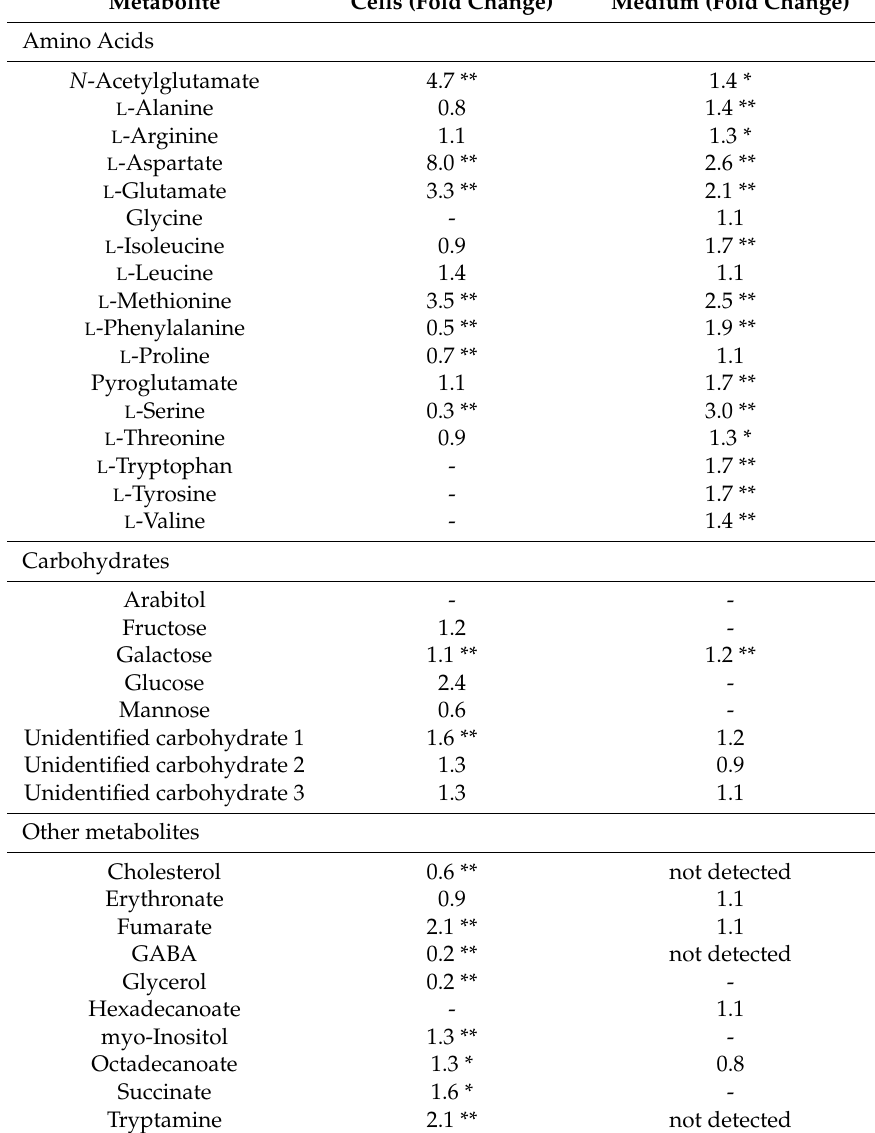
Table 1. Metabolites identified by PCA as contributing most to the variance between untreated and methamphetamine-treated rat B50 neuroblastoma cells, and the fold change observed in the treated cells and medium (n = 9), compared to the untreated ones (n = 9). ‘-’ indicates no change. Statistical significance was determined using Student’s t -test and is indicated as * p < 0.05; ** p <